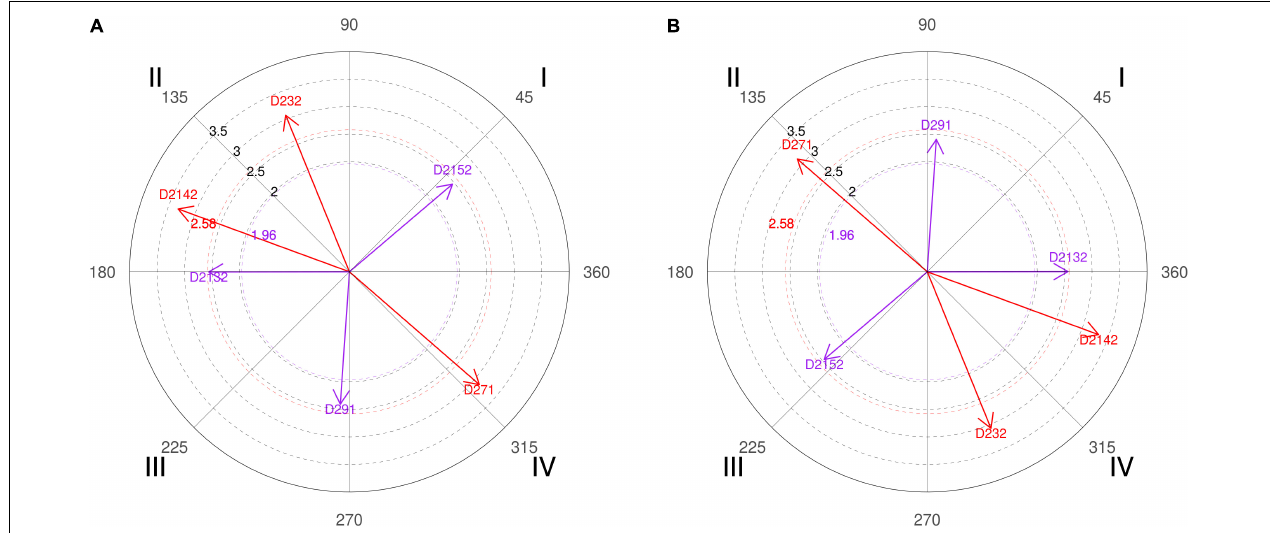
FIGURE 1 | (A,B) Relationship of conditioned behaviors that present a significant relationship with the focal behaviors “favorable evaluation” and “unfavorable evaluation” analyzing question 4 of the in-depth interviews. By way of example, in “favorable evaluation,” a total of 6 significant vectors were detected, of which 1 was in quadrant I, 2 were in quadrant II, 2 were in quadrant III, and 1 was in quadrant IV. In “unfavorable evaluation,” a total of 6 significant vectors were detected, of which 2 were in quadrant I, 1 was in quadrant II, 1 was in quadrant III, and 2 were in quadrant IV.